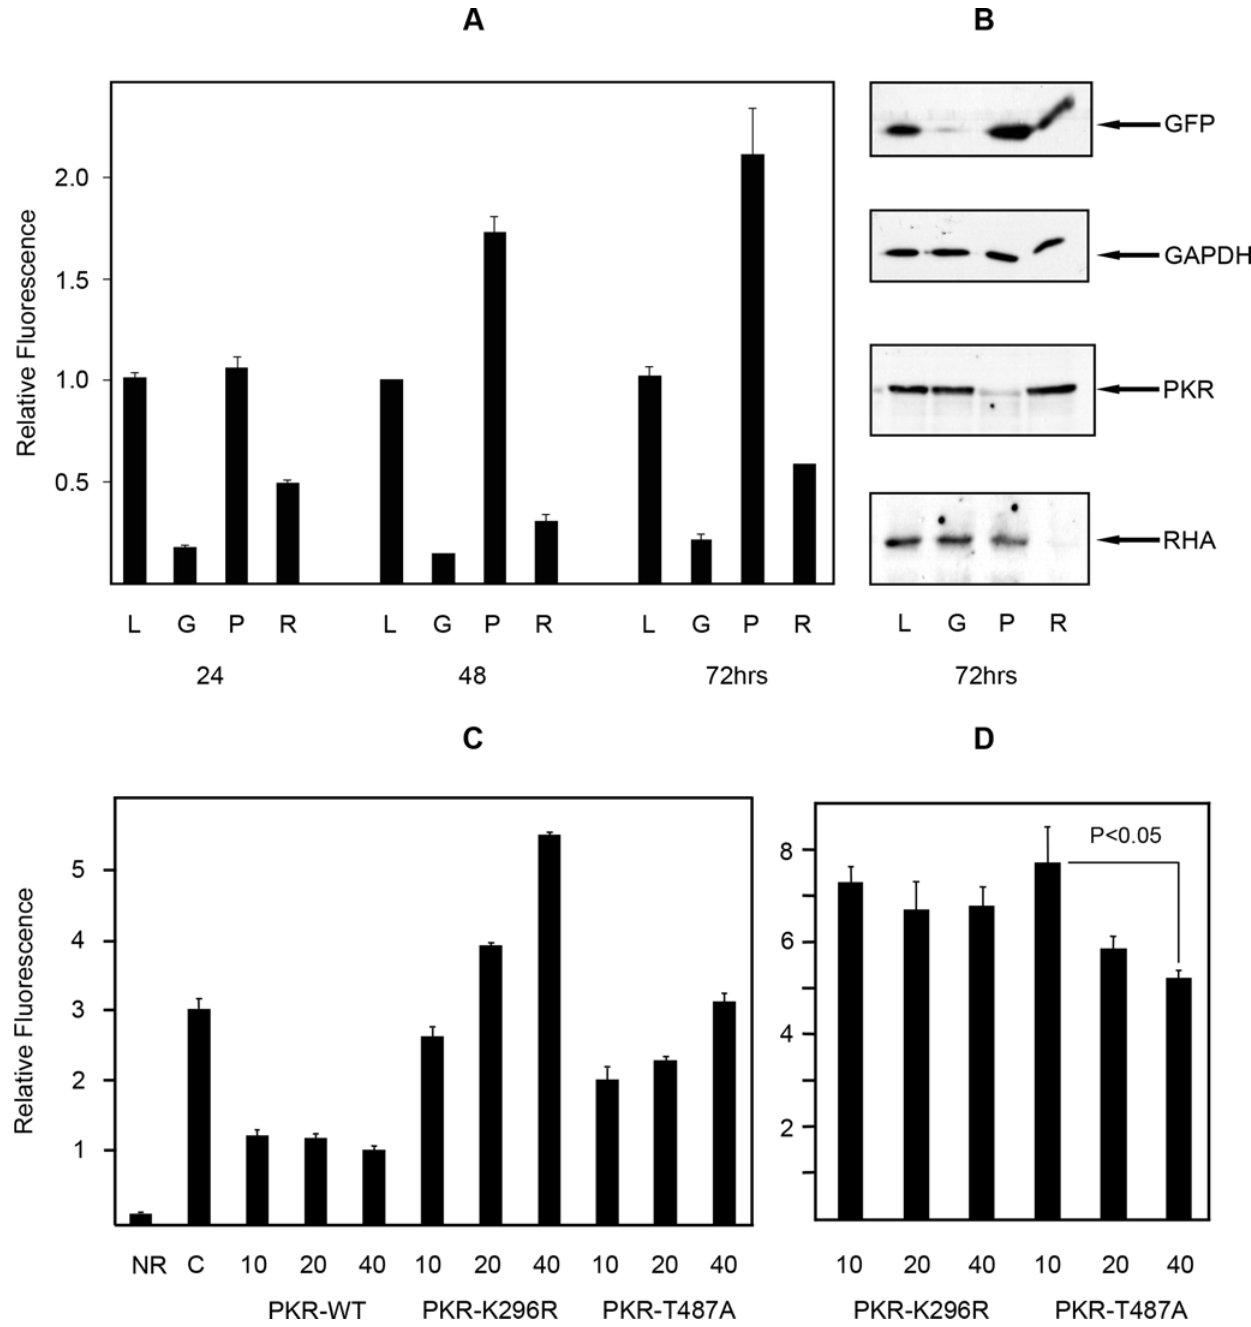
Figure 5. PKR inhibits RHA-mediated transactivation of HIV-1 LTR. (A) A bar graph representing the relative fluorescence levels in transiently transfected HEK293T cells using a HIV-1 LTR-EGFP reporter and siRNAs against lamin a/c (L), gfp (G), pkr (P), or rha (R), to measure the effect of PKR on RHA-mediated LTR-transactivation. Cell lystates were collected and assayed at three time points (24, 48, and 72 hours). Each value is the average of three independent measures, and the error bars represent the standard deviations. Fluorescence measures were corrected to a constitutive b actin- renilla reporter, then normalized to the Lamin a/c siRNA treatment. (B) Western blots of electrophoretically separated proteins, from HEK293T cells treated as in (A). Proteins were detected with antibodies to GFP, GAPDH, PKR, and RHA to show intended depression of targeted proteins and PKR- dependent control of RHA-mediated LTR-transactivation. (C) A bar graph representing the total relative fluorescence levels in HEK293T cells alone (NR), or transiently transfected with a HIV-1 LTR-EGFP reporter (C), and with wild-type PKR (PKR-WT), a kinase inactive mutant (PKR-K296R) or a mutant that does not regulate translation via eIF2 a (PKR-T487A), at three concentrations (10, 20, and 40 ng/well) to show kinase activity is required to regulate RHA-mediated induction of the HIV-1-LTR promoter sequence. Fluorescence levels are not normalized against a constitutive b actin reporter. Each value is the average of three independent measures, and the error bars represent the standard deviations. (D) The relative fluorescence levels in HEK293T cells transfected with the HIV-1 LTR-EGFP reporter and a kinase inactive mutant (PKR-K296R), or a translational control mutant (PKR-T487A) from (C) normalized against a constitutive b actin reporter to show specific, dose-dependent PKR-regulated inhibition of the RHA activity. A t-test was performed on the data to establish the statistical significance of the observed PKR-mediated reduction in the LTR reporter.